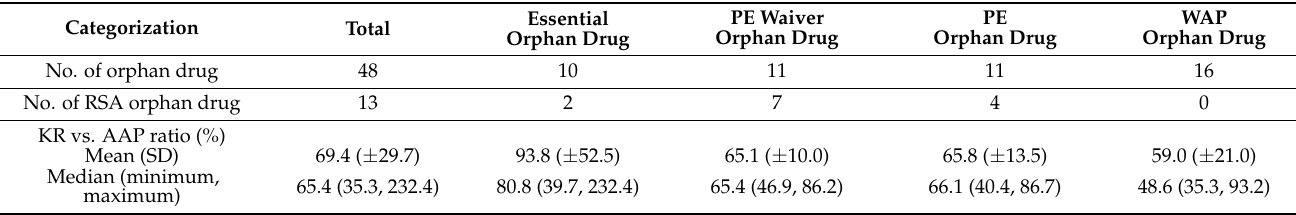
Table 1. Categorization of new orphan drugs according to pricing and reimbursement pathways in South Korea (listed during the period January 2007–March